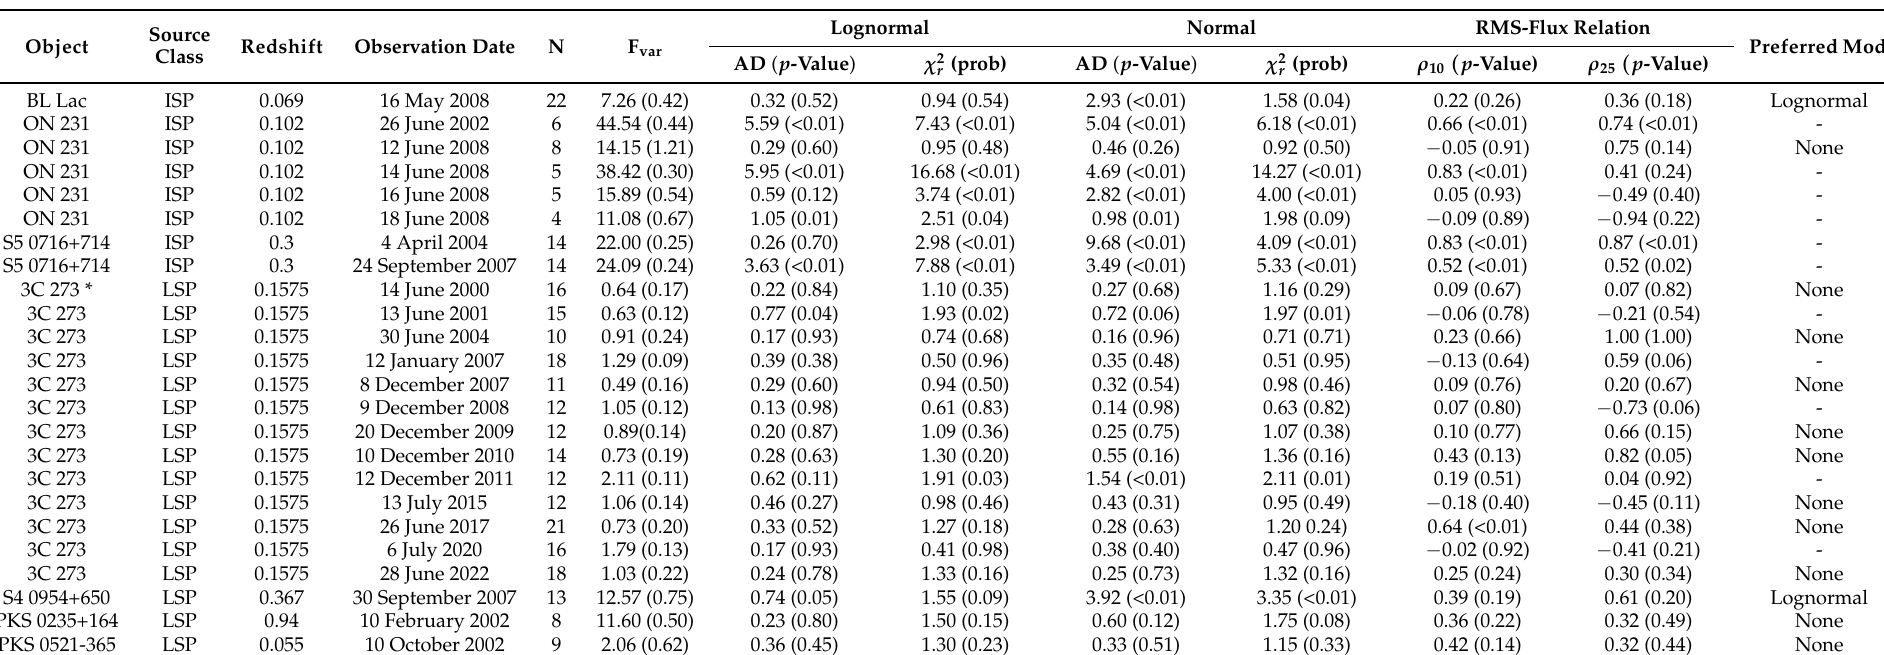
Table 1. Observation log of ISP and LSP blazars with their corresponding F var , results of AD test and χ 2 test for lognormal and normal PDF fitting and results of the RMS–Flux